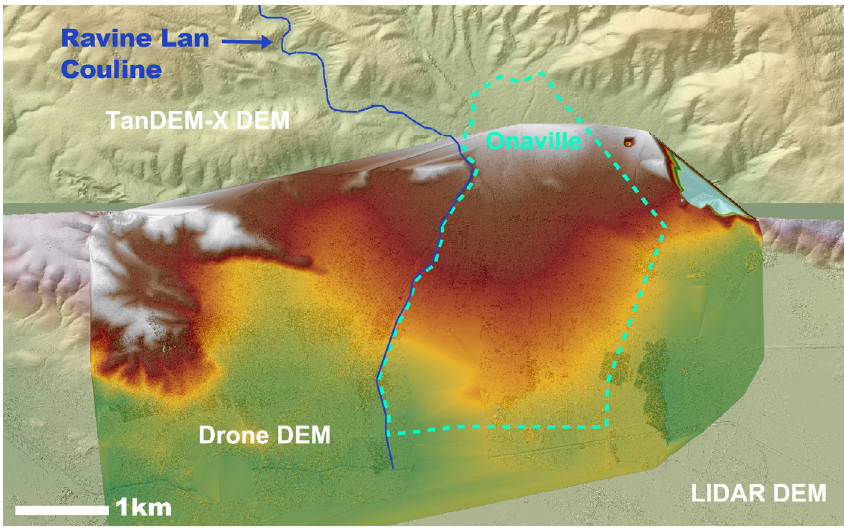
Figure 6. Spatial extent of the three DEMs used in this